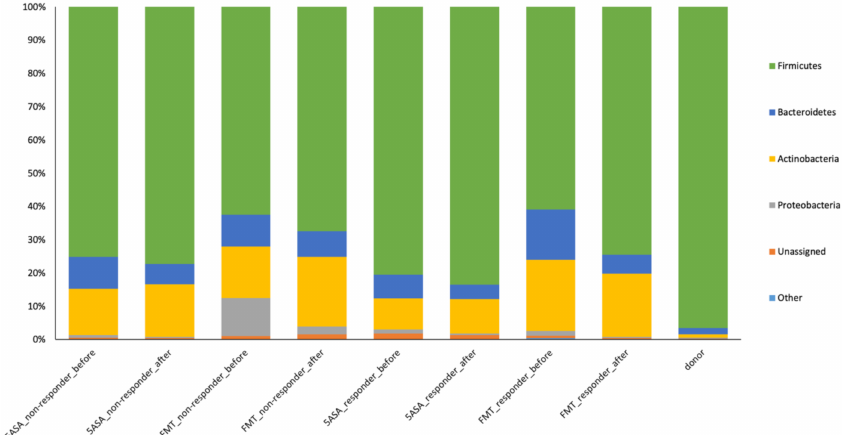
Figure 2. Relative abundance of fecal bacteria at the phylum level in all 60 samples from 16 ulcerative colitis (UC) patients with active left-sided colitis and the donor grouped by therapy type (FMT, 5-ASA), responsiveness (responder, non-responder), and time point of a sample collection (before therapy or at multiple time points after therapy initiation). Fusobacteria, Tennericutes, Acidobacteria, Planctomyceles, and TM7 with low relative abundance are summarized as